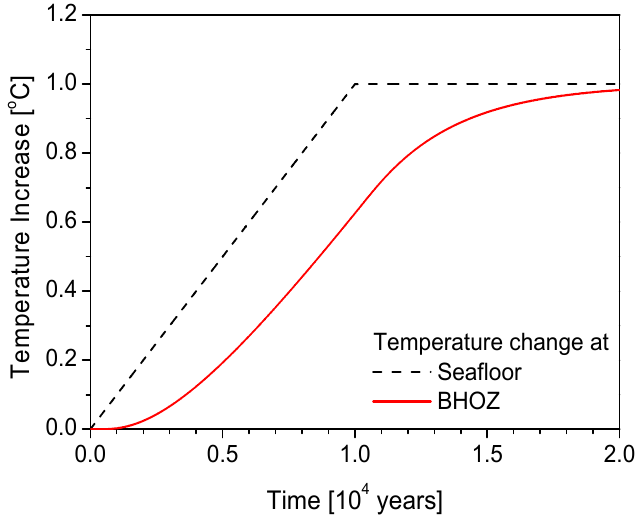
Figure 4. Thermal response at the BHOZ due to the increase in the seafloor